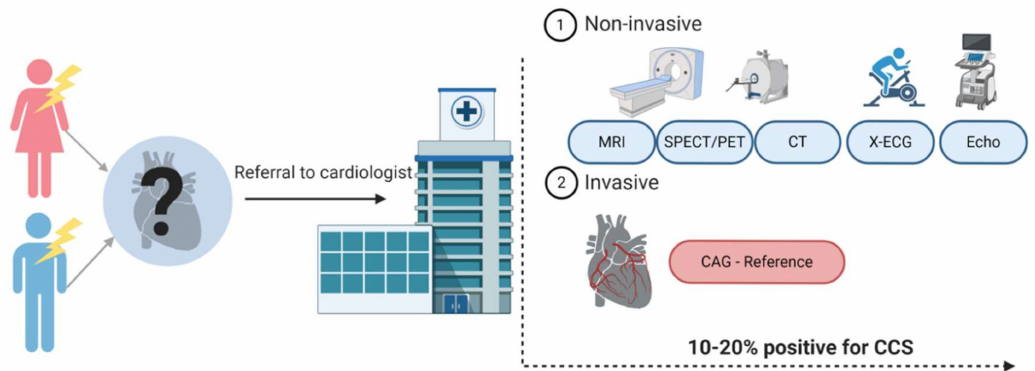
Figure 1. Diagnostic track of patients with chest pain suspected for a chronic coronary syndrome (CCS). Patients suspected of CCS are often referred to a cardiologist. Patients undergo either noninvasive or invasive tests. The choice for one of the tests is based on the pre-test probability of a patient having CCS and availability in the hospital. Created with